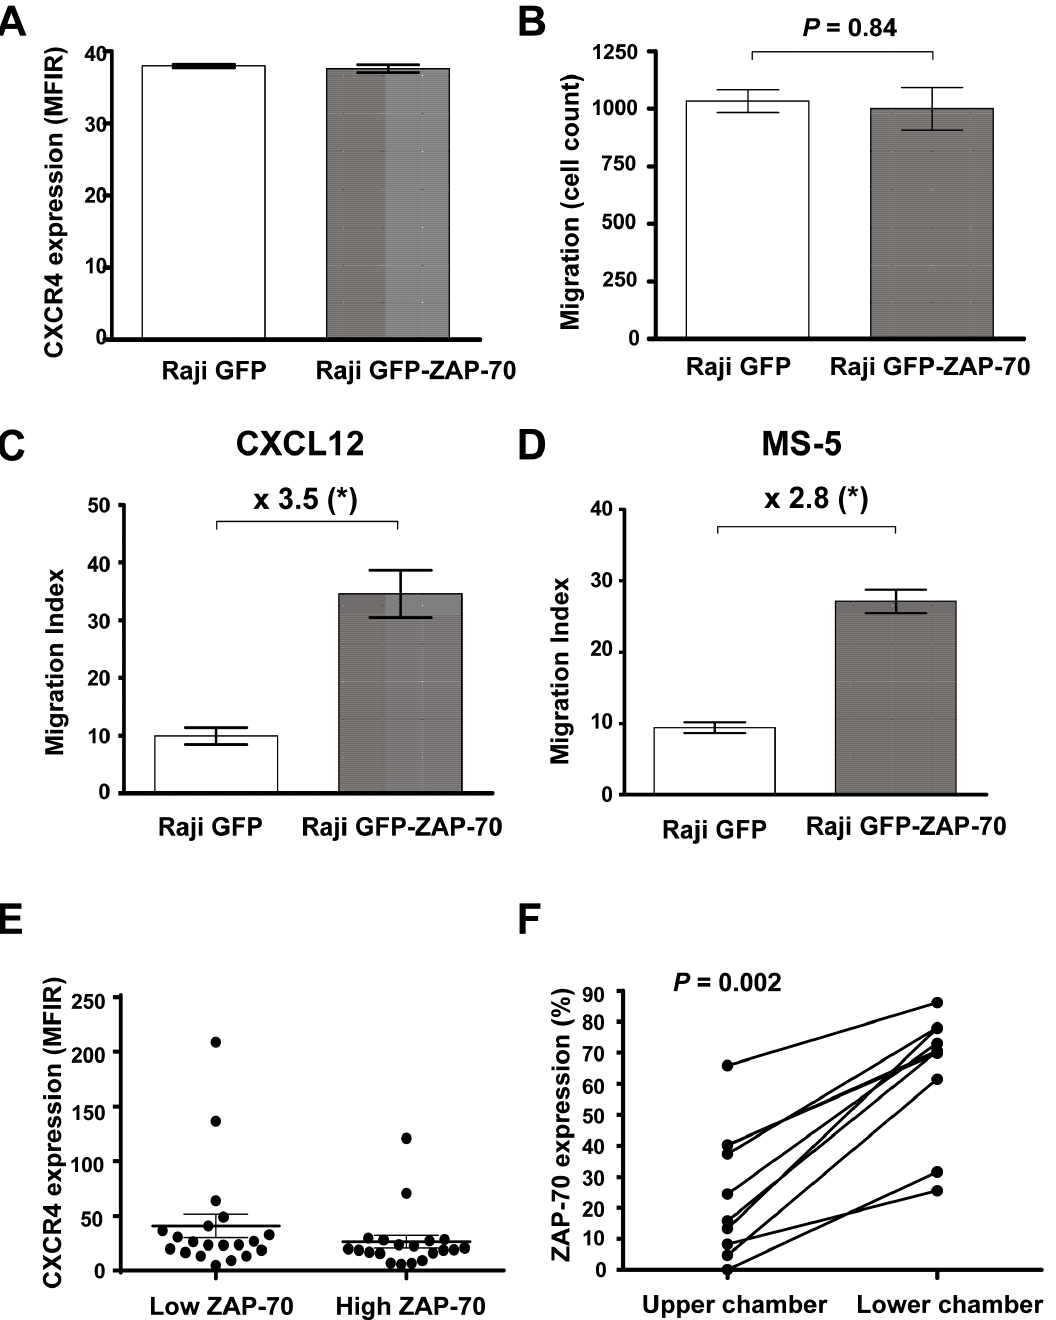
Figure 3. ZAP-70-positive cells have increased migrative capacity toward CXCL12 and the BMSC cell line MS-5. (A) Mean fluorescence intensity ratio (MFIR) of CXCR4 surface staining in Raji GFP and Raji GFP-ZAP-70. (B) Raji transfectants were subjected to migration assay for 4 hours at 37 u C in 5% CO 2 with medium containing CXCL12 (100 ng/mL) in the upper and lower chamber. Migrated cells were counted with a Navios cytometer under a defined flow rate for 5 minutes. (C).Raji transfectants were subjected to migration assay toward CXCL12 (100 ng/mL) or the stromal cell line MS-5 (D) for 4 hours at 37 u C in 5% CO 2 and cells in the lower chamber were counted with a Navios cytometer under a defined flow rate for 5 minutes. * P , .05 (Mann-Whitney test). Results are shown as the mean 6 SEM of at least 4 independent experiments. (E) MFIR of CXCR4 surface staining in 20 patients with low ZAP-70 expression and 20 patients with high ZAP-70 expression. Results in the graph show mean 6 SEM. (F) Peripheral blood mononuclear cells from 10 patients with CLL were subjected to migration assays toward CXCL12 (100 ng/mL) for 6 hours at 37 u C in 5% CO 2 . The percentage of CD19 + /CD5 + /CD3- CLL cells expressing ZAP-70 was determined in the cellular fraction remaining in the upper chamber and in the cellular fraction of transmigrated cells for each patient by flow cytometry. Wilcoxon test was used, and P , .05 was considered significant.